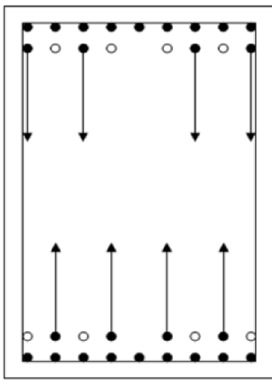
Fig. 17. Symmetric and alternate arrangement of X-braced rebar